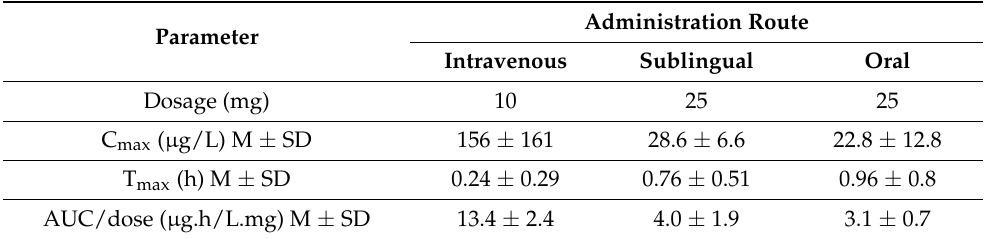
Figure 1. The molecular structure of ketamine, S-ketamine and R-ketamine. Table 1. Single administration of ketamine: selected pharmacokinetic parameters.